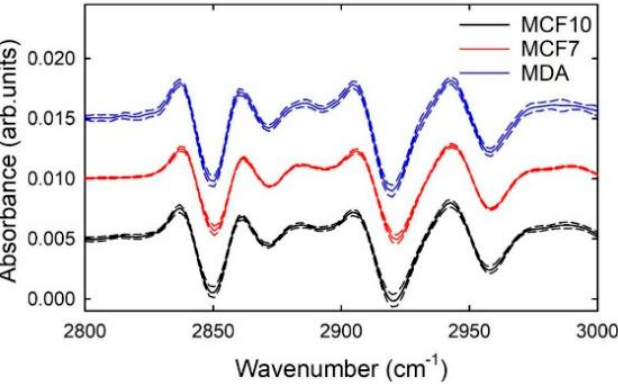
Figure 2. Mean second derivative signals of the SNV normalized FTIR spectra of MCF10A (continuous black line), MCF7 (continuous red line), and MDA (continuous blue line) cells. Standard deviation spectra are also reported as dashed lines. The spectra are vertically shifted for clarity of purpose.